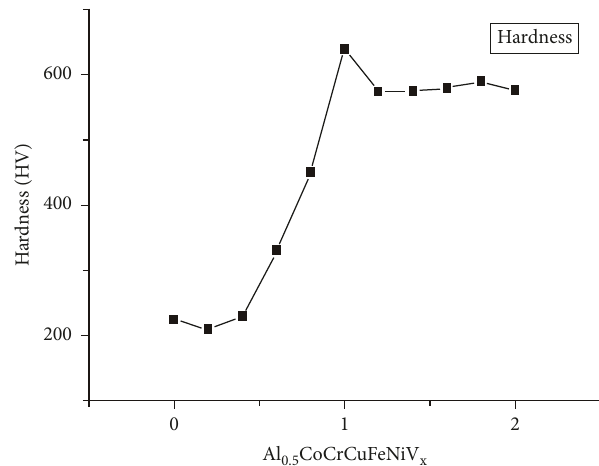
Figure 13: Hardness of Al 0.5 CoCrCuFeNiV x HEA with different vanadium contents